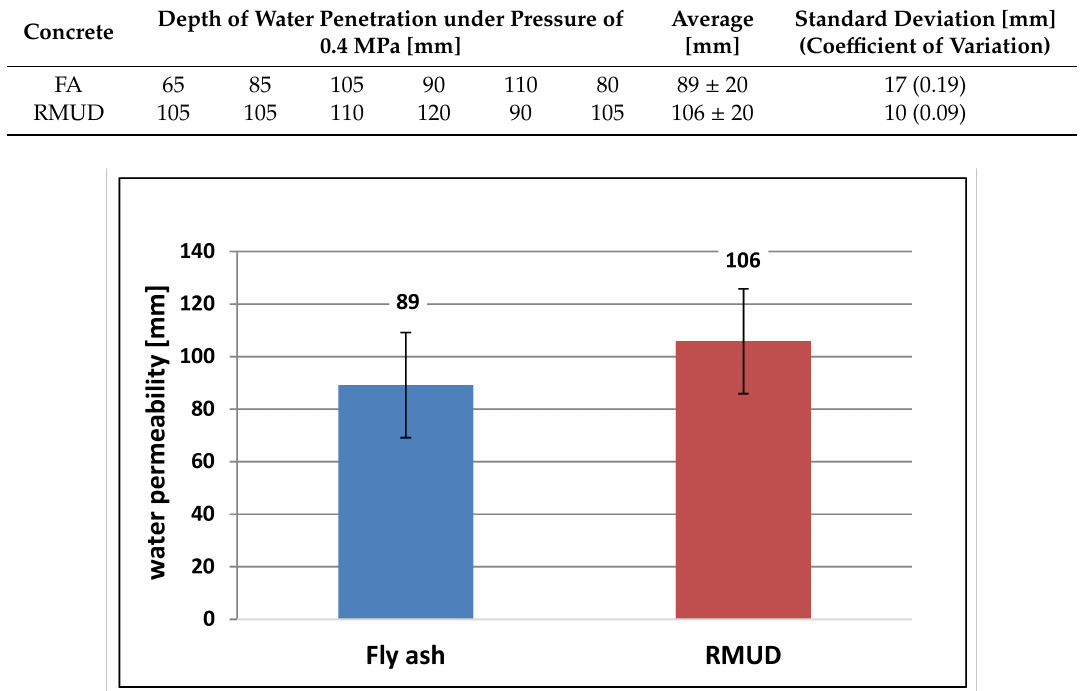
Figure 8. Average values of water permeability through